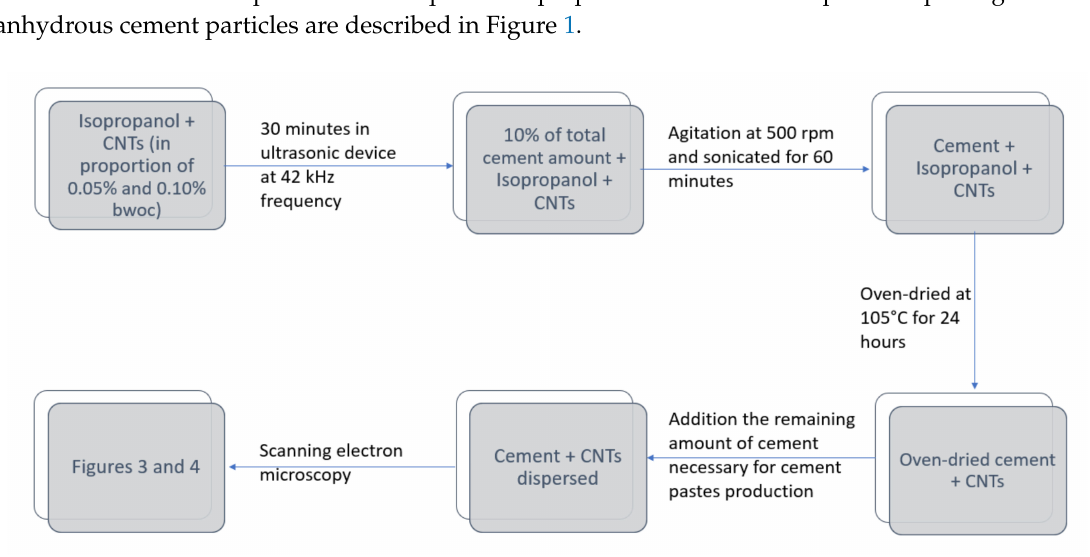
Figure1. Theadoptedmethodologytodispersecarbonnanotubes(CNTs)inasuspensionofisopropanol.